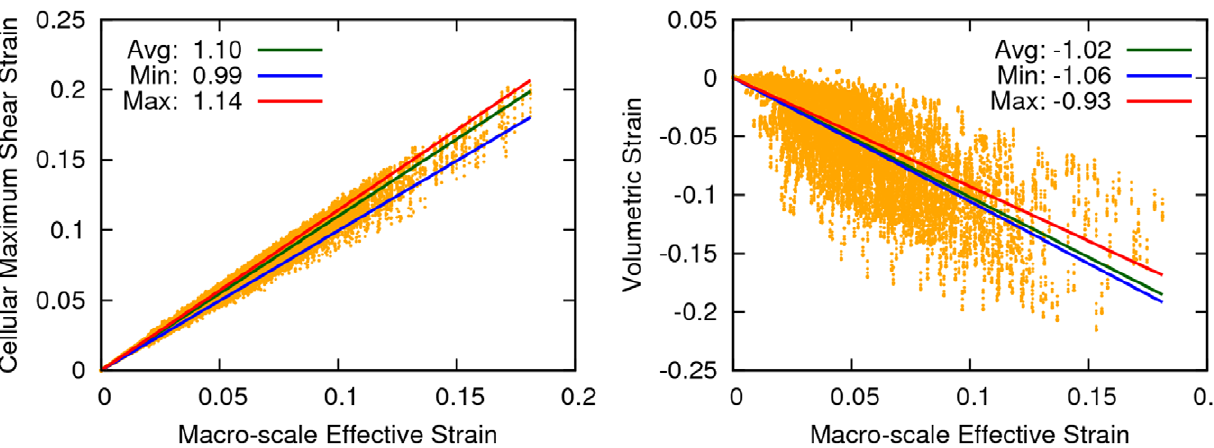
Figure 9. The volume-averaged maximum shear strain (left) and volumetric strain (right) for the 11 cell model plotted against the macro-scale effective strain. Deformation metrics such as those shown here, may have additional implications to understand cellular damage mechanisms as well as the onset of mechano-biological function, which change in aspect ratio may not provide. For example, pure cell dilation will result in a volumetric strain, but not a change in aspect ratio. The large bandwidth of the volumetric strain also suggests that a direct linear relationship between the macro- and micro-scales may not be acceptable for all characterizations of deformation.